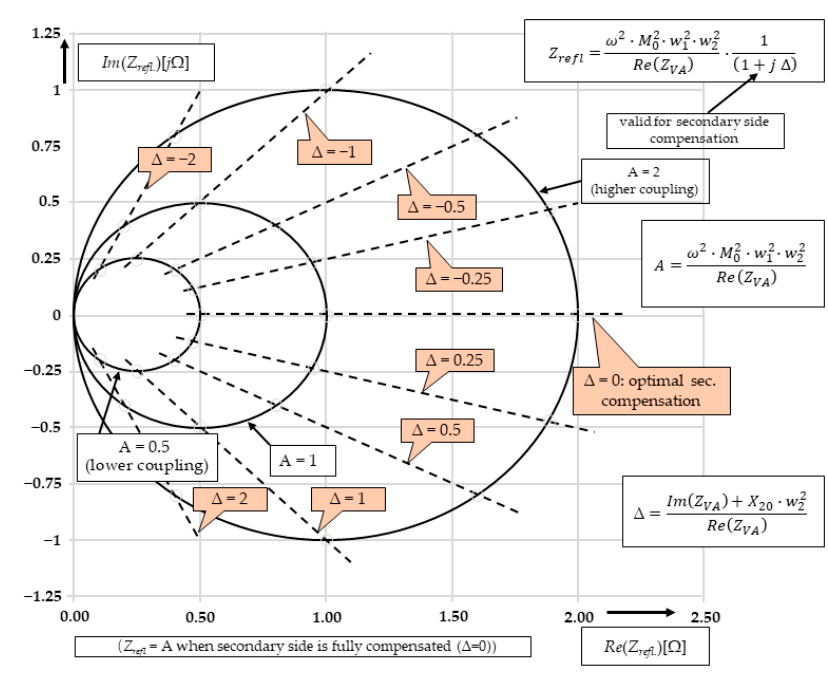
Figure 12. The behavior of the port impedance.